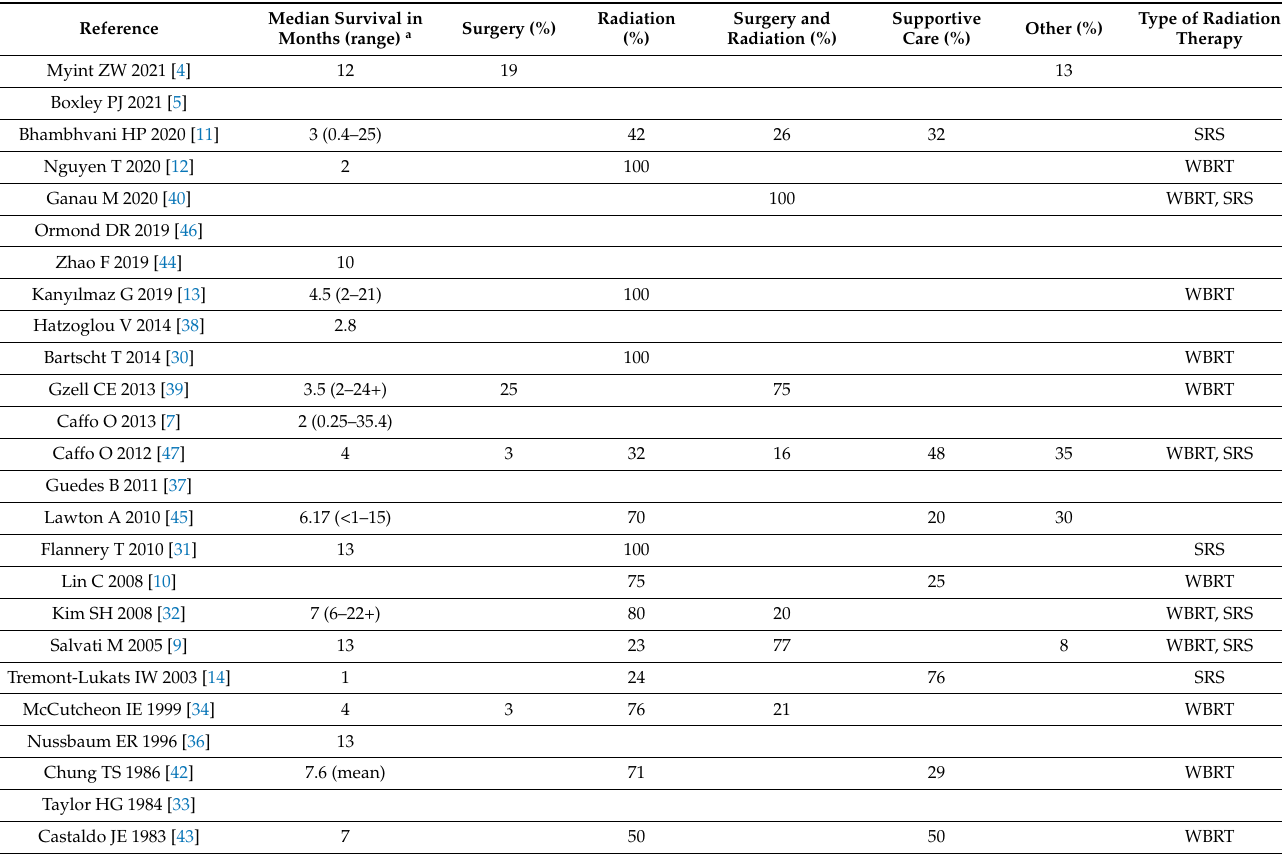
Table 3. Brain metastases